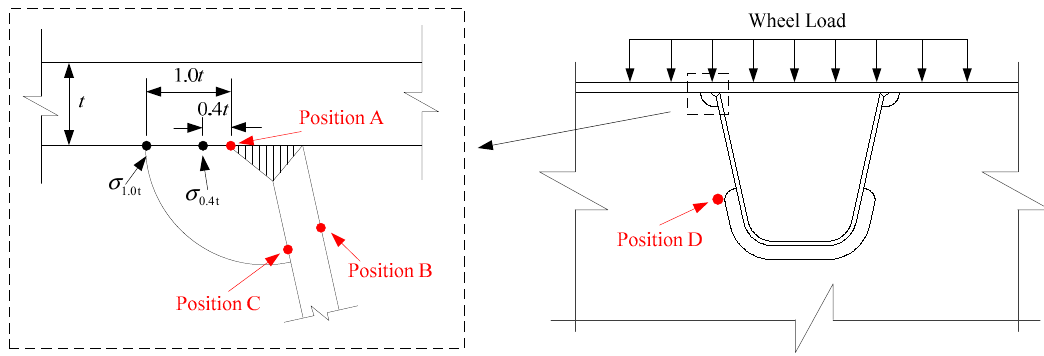
Figure 7. Vulnerable position of orthotropic deck.